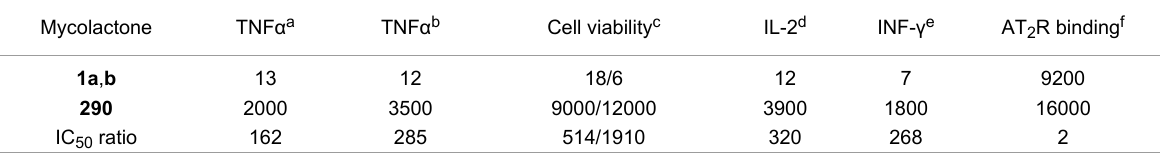
a Suppression of PMA-induced TNF α production in PMN cells. b Suppression of LPS-induced TNF α production in MDM cells. c Cell viability assessed by an MTT reduction assay after 72 h of incubation (MDM/HDF cells). d Suppression of PMA/IO-induced IL-2 production in CD4 + cells. e Suppression of PMA/IO-induced IFN- γ production CD4 + cells. f Competitive binding to human AT 2 R against 0.01 nM of the agonist radioligand [ 125 I]-CGP42,112A ( K d = 0.01 nM) in transfected HEK